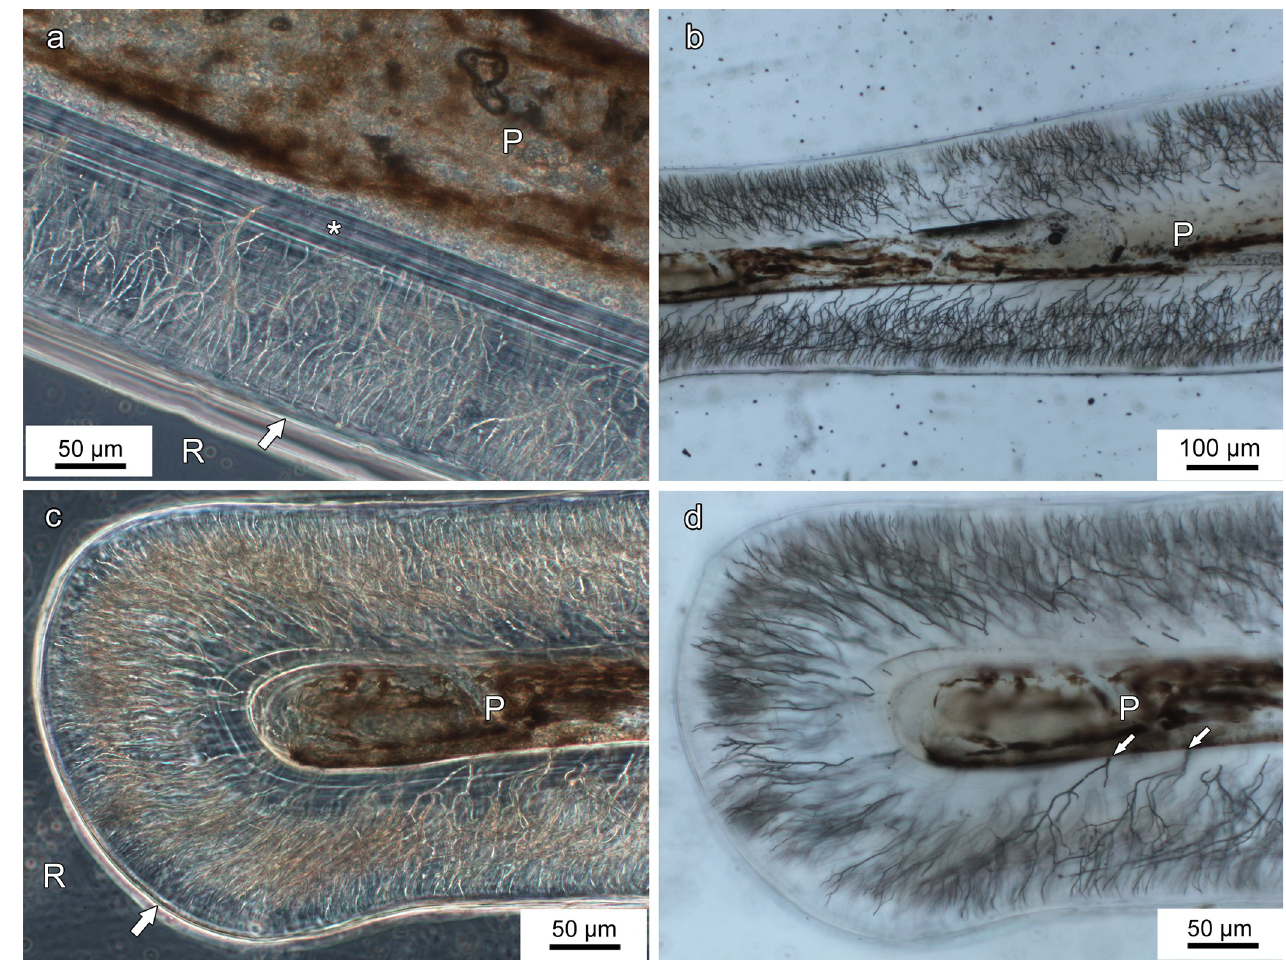
Fig 4. Light micrographs of longitudinal ground sections of lower oral jaw teeth of Anoplogaster cornuta . (a) Anterior wall of the shaft of the left first dentary tooth showing intense ramification of tubules in central dentin, and inner (juxtapulpal) dentinal zone (asterisk) with only few tubules. P: Pulp cavity. Arrow points to the tooth surface. A cleft between the tooth surface and the embedding resin (R) appears as a bright zone. Transmitted light with phase- contrast. (b) S haft of left third dentary tooth showing extension and ramification of dentinal tubules, tooth tip to left of image. P: Pulp cavity. Normal transmitted light. (c) Tip of left third dentary tooth showing ramification of dentinal tubules in central dentin. Note lack of an enameloid cap. P: Pulp cavity. Arrow points to tooth surface. A cleft between tooth surface and embedding resin (R) appears as a bright zone. Transmitted light with phase-contrast. (d) Tip of left third dentary tooth showing that the dentinal tubules typically cannot be traced up to the tooth surface. Note lack of an enameloid cap. Arrows: Openings of dentinal tubules at the pulpal border. P: Pulp cavity. Normal transmitted